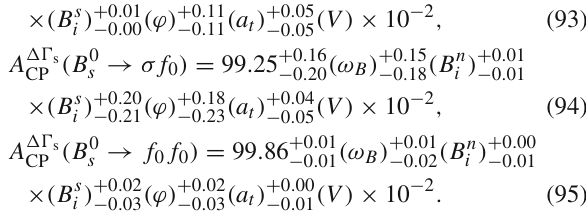
Fig. 3 Dependence of the direct CP-violating asymmetries A dir the blue-dashed line, and the magenta-dotted line correspond to final states σσ , σ f 0 , and f 0 f 0 ,